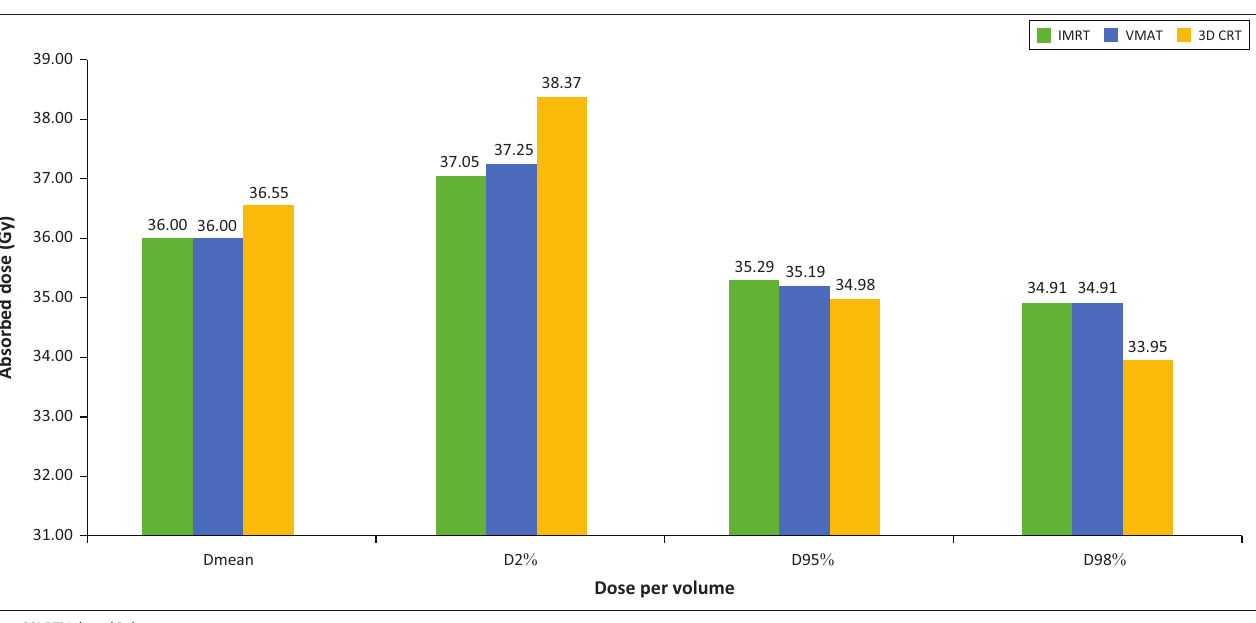
FIGURE 1: Planned target volumes dosimetry for the three radiation therapy